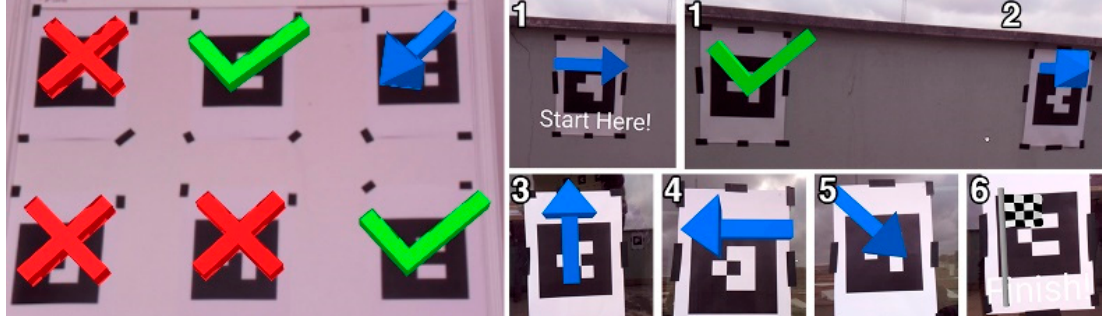
Figure 11. Markers on a 2 by 3 grid (left) and an example of a sequence performed in the correct order in a real scenario (right).